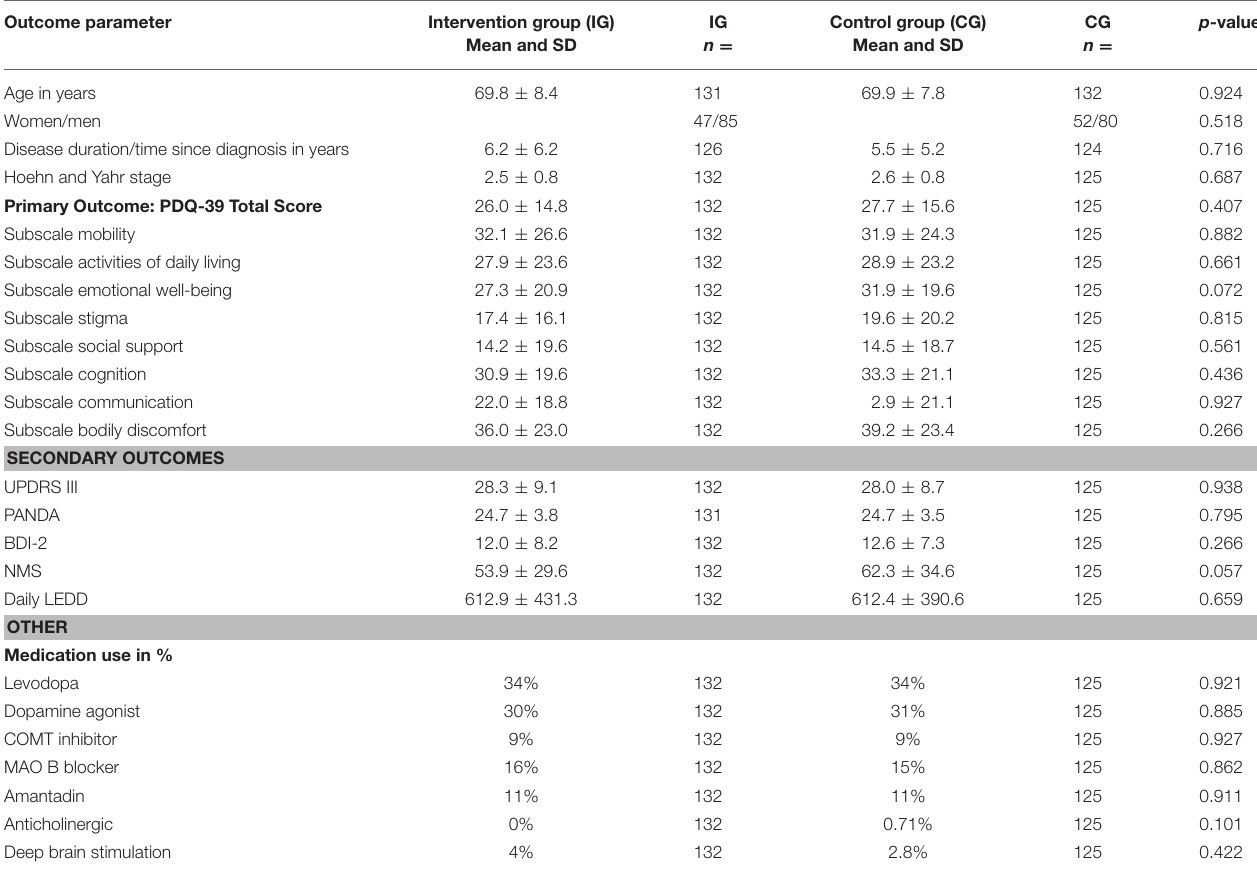
TABLE 1 | Baseline characteristics IG and CG. Outcome